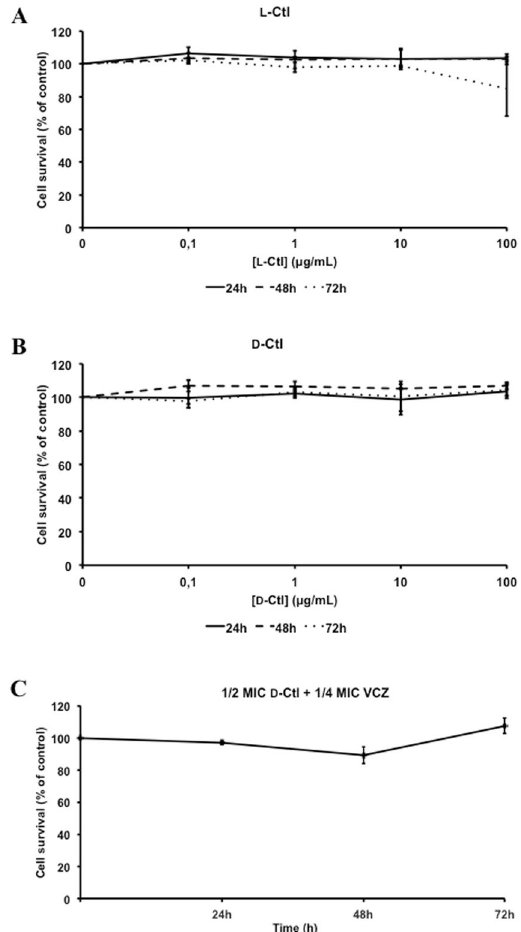
Figure 2. Cytotoxicity of L-Ctl and D-Ctl against human gingival fibroblasts (HGF-1) using MMT assays. L-Ctl ( A ) or D-Ctl ( B ) were incubated with HGF-1 cells at different concentrations (0 μ g/mL, 0.1 μ g/mL, 1 μ g/ mL, 10 μ g/mL, 100 μ g/mL) for 24 h, 48 h and 72 h. The combination ½ MIC D-Ctl + ¼ MIC VCZ ( C ) was also incubated with HGF-1 cells for 24 h, 48 h and 72 h. The results obtained are expressed as percentage of cell survival. For each panel, the average of at least three independent experiments is